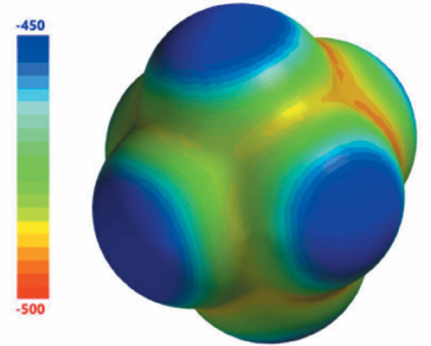
Figure 11 Electrostatic potential map (kcal mol (cid:3) 1 ) for the hexafluoridophosphate anion. Note the relatively small range of 50 kcal mol (cid:3) 1